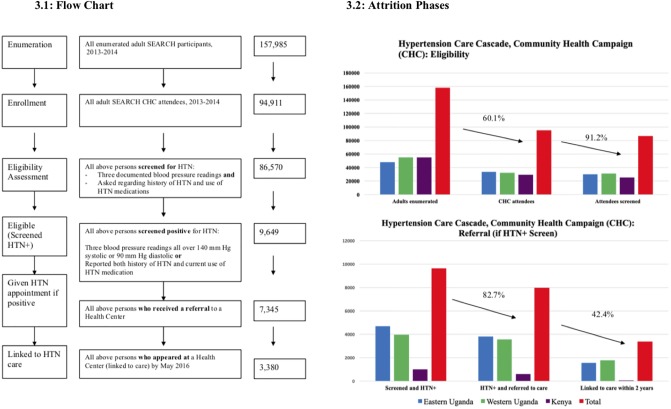
Consort diagram, fidelity, and outcome measures for CHC hypertension cascade.Flow chart depicts stepwise care cascade; bar graphs depict size of cumulative attrition.